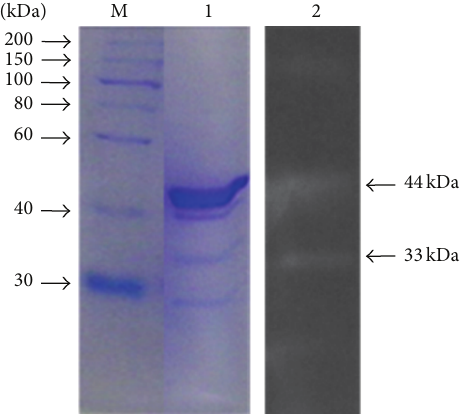
Figure 4: Zymogram analysis shows presence of two xylanases in crude enzyme preparation of strain X1 grown on birchwood xylan. Lane 1: Coomassie brilliant blue stained gel; Lane 2: Congo red followed by acetic acid stained gel; and Lane M: protein molecular weight